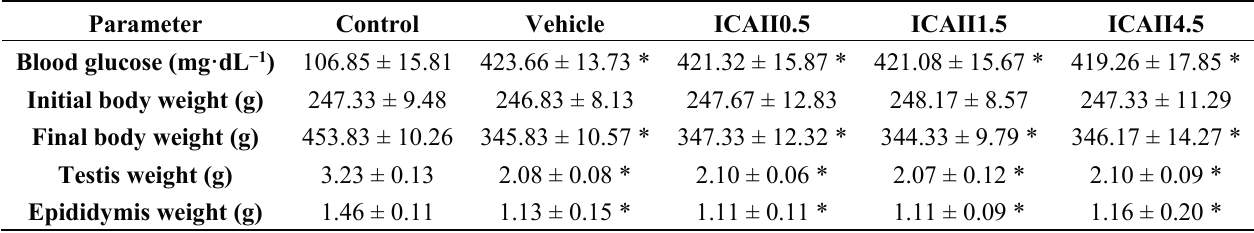
Table 1. Levels of blood glucose, body weight, reproductive organs weight, and epididymal sperm parameters.